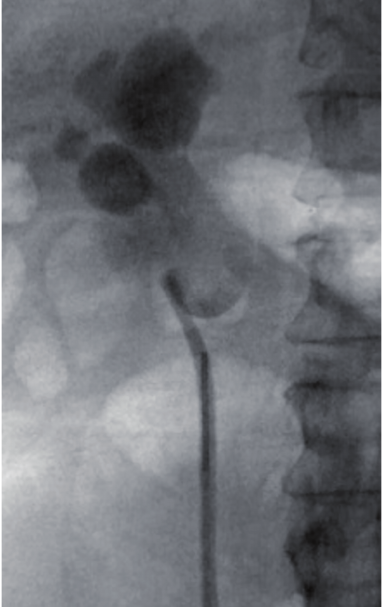
Figure-2 - Right retrograde pyelogram performed prior to stent placement revealed moderate hydronephrosis and features concerning for ureteropelvic junction obstruction.